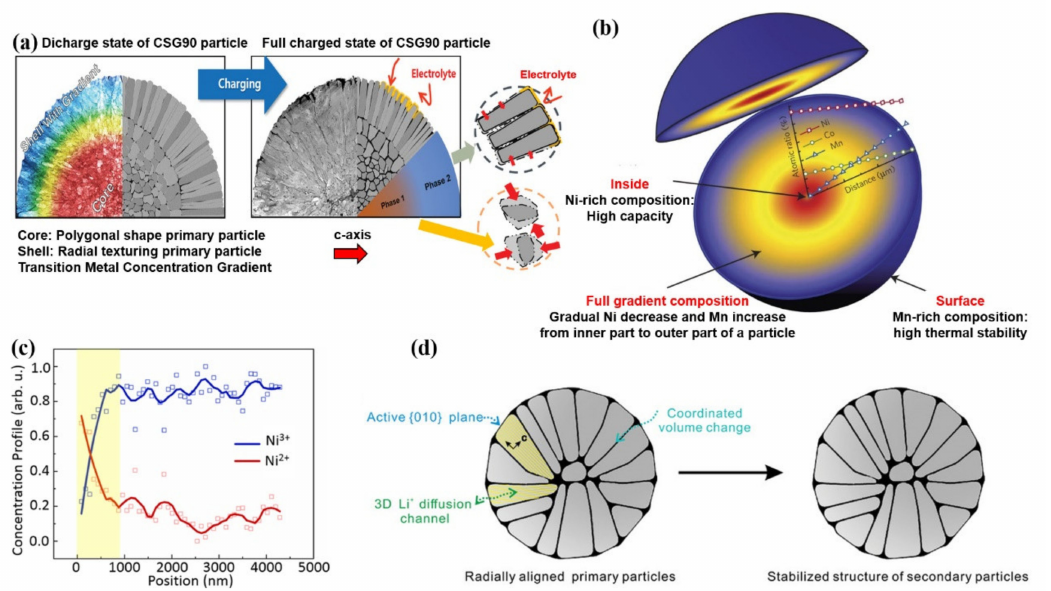
Figure 10. ( a ) Schematic illustration for CSG90 and CC90 cathodes at discharge and charge state showing the internal morphological difference and the sustained damage. Reproduced with per- mission from ref. [111]. Copyright 2019 John Wiley and Sons. ( b ) Schematic illustration for the FCG lithium transition-metal oxide particle. Reproduced with permission from ref. [112]. Copyright 2012 Springer Nature. ( c ) The Ni 2+ and Ni 3+ concentrations from surface to the center regions. Reproduced with permission from ref. [114]. Copyright 2021 Springer Nature. ( d ) Schematic illustration for the relationship between stress distribution and particle internal structure. Reproduced with permission from ref. [115]. Copyright 2019 John Wiley and